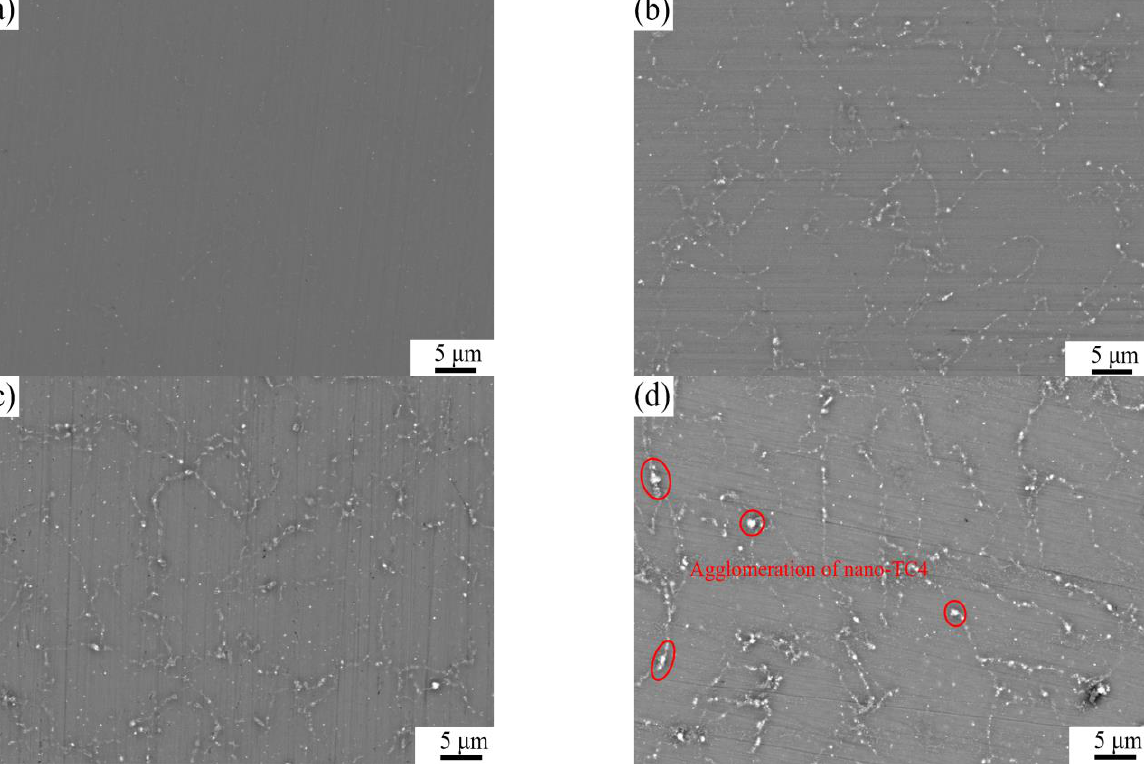
Figure 7. SEM microstructures of ( a ) AZ31, ( b ) 0.5 wt.%TC4/AZ31, ( c ) 1 wt.%TC4/AZ31, and ( d ) 1.5 wt.%TC4/AZ31 as-extruded composites. ( d ) 1.5 wt.%TC4/AZ31 as-extruded